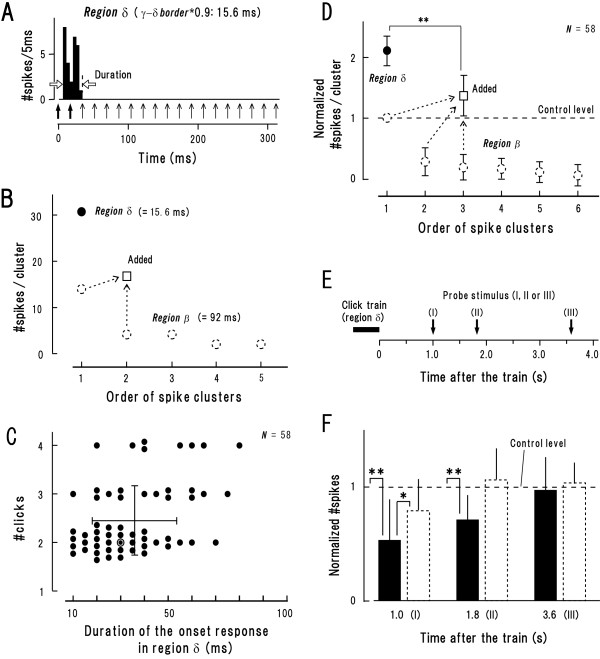
Accumulation effect of responses in region δ (at 0.9 multiples of the γ-δ border) (A-D) and its durability (E, F). The format in A, B, D, E, F is the same as in Figure 4A-E, respectively. A: Peri-stimulus time histogram of the same neuron as in Figure 4A. The initial two clicks (arrows, bold) presumably contributed to the onset response (see text). B: #Spikes involved in the onset response (filled circle). For comparison, the data in Figure 4B was appended (in region β; broken circles) with the square representing #spikes elicited by the initial two clicks. C: Population data (mean ± SD) of joint distribution for the duration of the onset response (abscissa) and the number of clicks involved in it (#clicks, ordinate; mean = 2.4). The double circle represents the data in A. D: Population data of the normalized #spikes in region δ (filled circle). For comparison, the data in Figure 4C was appended (in region β; broken circles) with the square representing #spikes elicited by the initial three (> 2.4) clicks. E: Procedures for measuring the responsivity after the train that elicited region δ responses. F: Population data of the normalized #spikes measured according to E (filled bar). For comparison, the data in Figure 4E was appended (after region β; broken bar). *P < 0.05, **P < 0.01 (paired t-test).